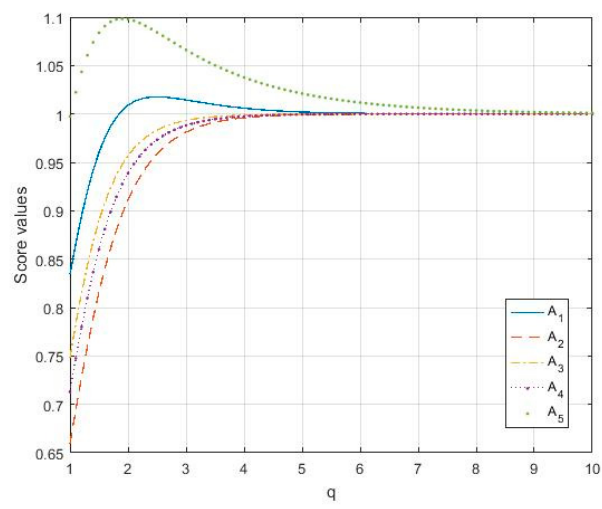
Figure 2. Score values of the alternatives when q ∈ ( 1,10 ) based on the q -RPFDWDHM operator.